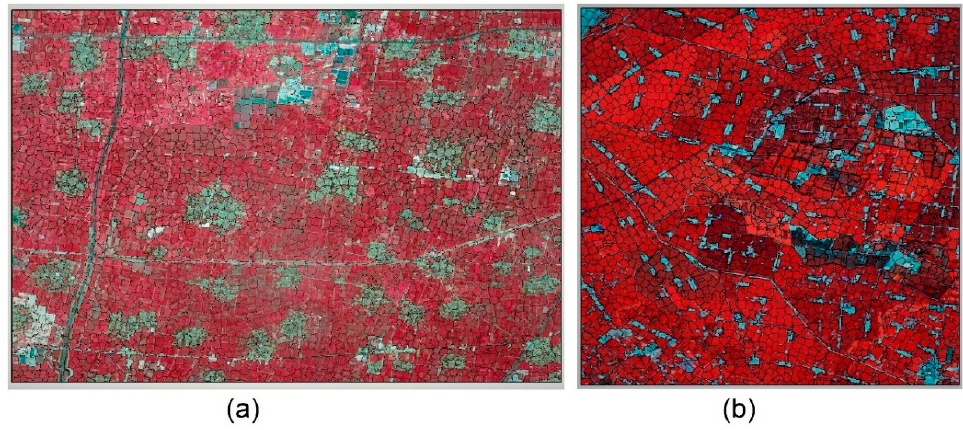
Figure 3. Field extraction from the simple linear iterative clustering (SLIC) method in the research regions: ( a ) Guantao field and ( b ) Daman field.